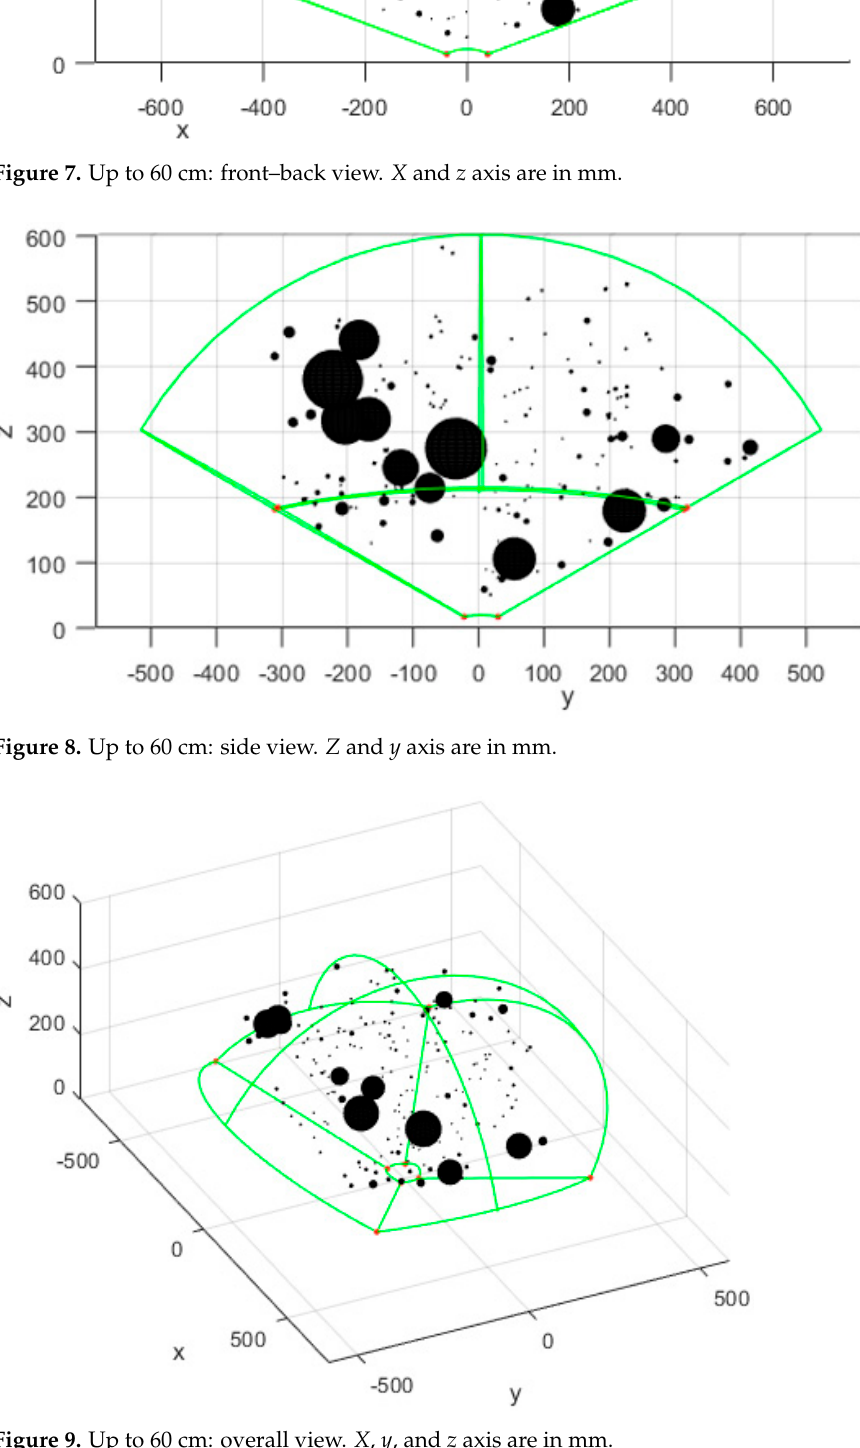
Figure 7. Up to 60 cm: front–back view. X and z axis are in mm.